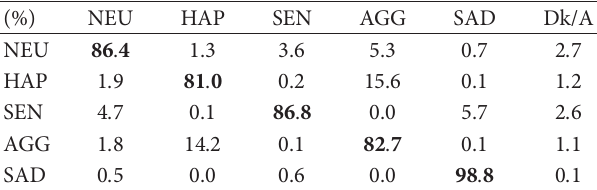
Table 2: Average confusion matrix (%) for the subjective test (the maximum correct classification value is in